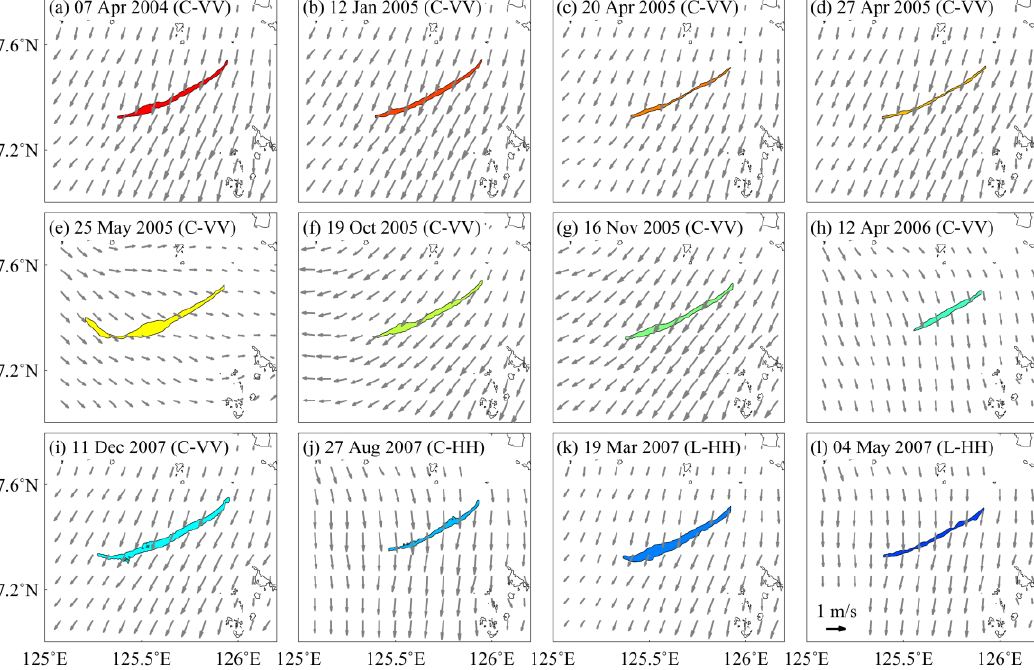
Figure 7. Underwater bathymetric features over the tidal channel, extracted from the SAR images by the objective detection method. The background vector fields indicate tidal currents at the image acquisition time.